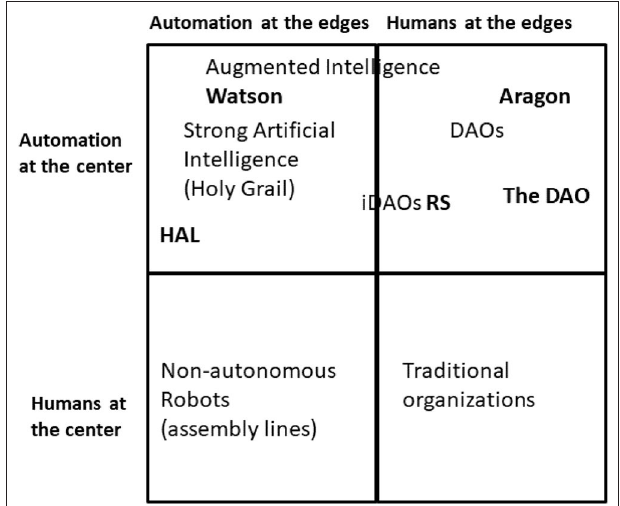
FIGURE 12 | A quadrant of organizations. Adapted from https://blog. ethereum.org/2014/05/06/daos-dacs-das-and-more-an-incomplete-